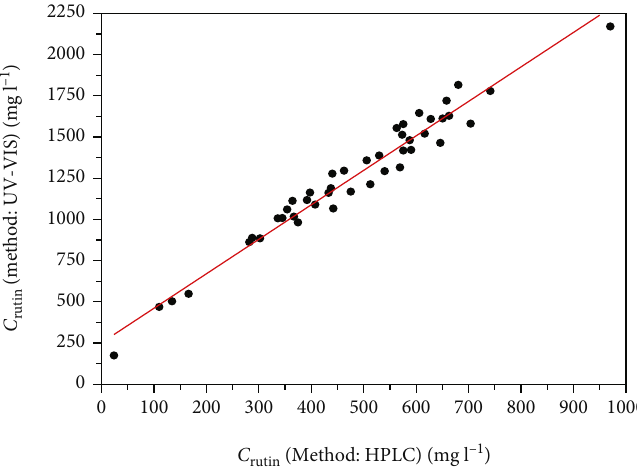
Figure 3: Concentration of rutin obtained by UV-Vis as a function of the rutin concentration obtained by HPLC for the extraction